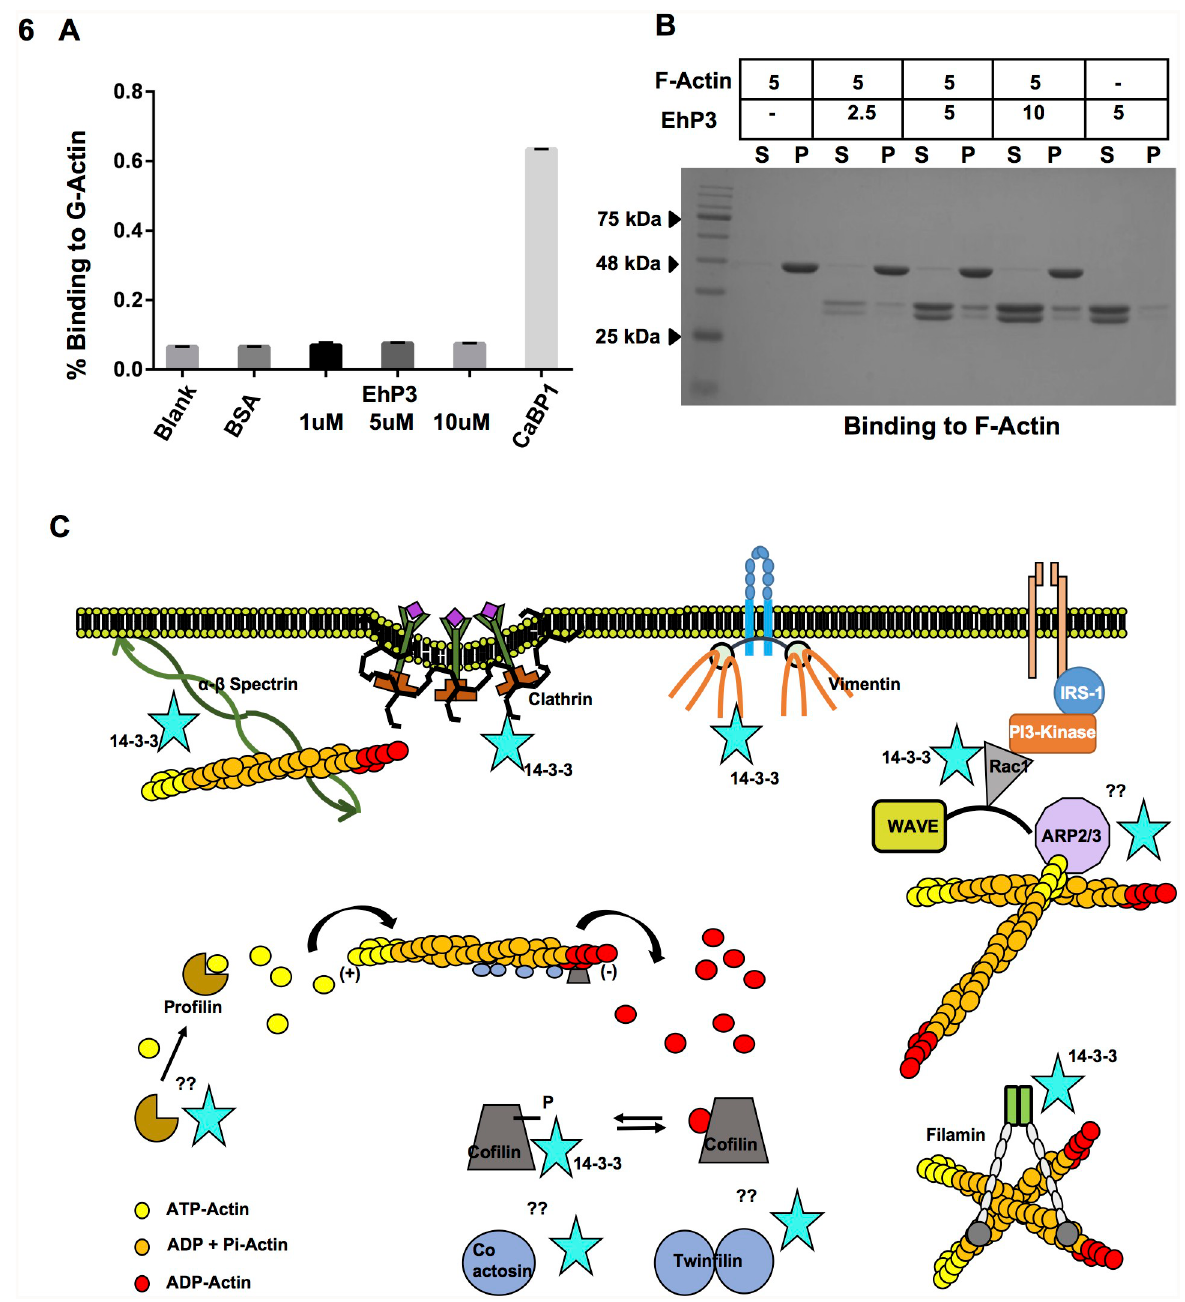
Fig 6. Binding of EhP3 to actin. (A) Graph depicts analysis of G-actin solid phase plate binding assay for EhP3. The histogram represents relative mean intensity of fluorescence observed on binding to actin. CaBP1 was used as binding control. (B) Immunoblot analysis of the F-actin co- sedimentation assay for EhP3. Purified EhP3 protein incubated at different concentration (2.5, 5, 10 μ M) with polymerised G-actin (5 μ M) or without F-actin were separated into supernatant (S) and pellet (P) fractions by high speed ultracentrifugation and analysed by SDS PAGE. (S- supernatant, P-pellet). (C) Model summarising reported/predicted interactions between 14-3-3 and actin regulatory proteins that controls cell cytoskeleton remodelling in higher systems. The 14-3-3 protein interact indirectly or directly with many Rho regulators, particularly Rac1 binds directly with 14-3-3. The 14-3-3 proteins also control the activity of the ubiquitous F-actin depolymerizing and severing factor cofilin via binding and stabilizing cellular phosphocofilin levels. Interaction of 14-3-3 with other proteins of the ADF/cofilin family (Twinfilin, Coactosin) warrants further investigation. The binding of 14-3-3 with structural proteins (filamin, clathrin), anchoring proteins (spectrin), sequestering proteins (profilin) have been depicted in the proteome studies.